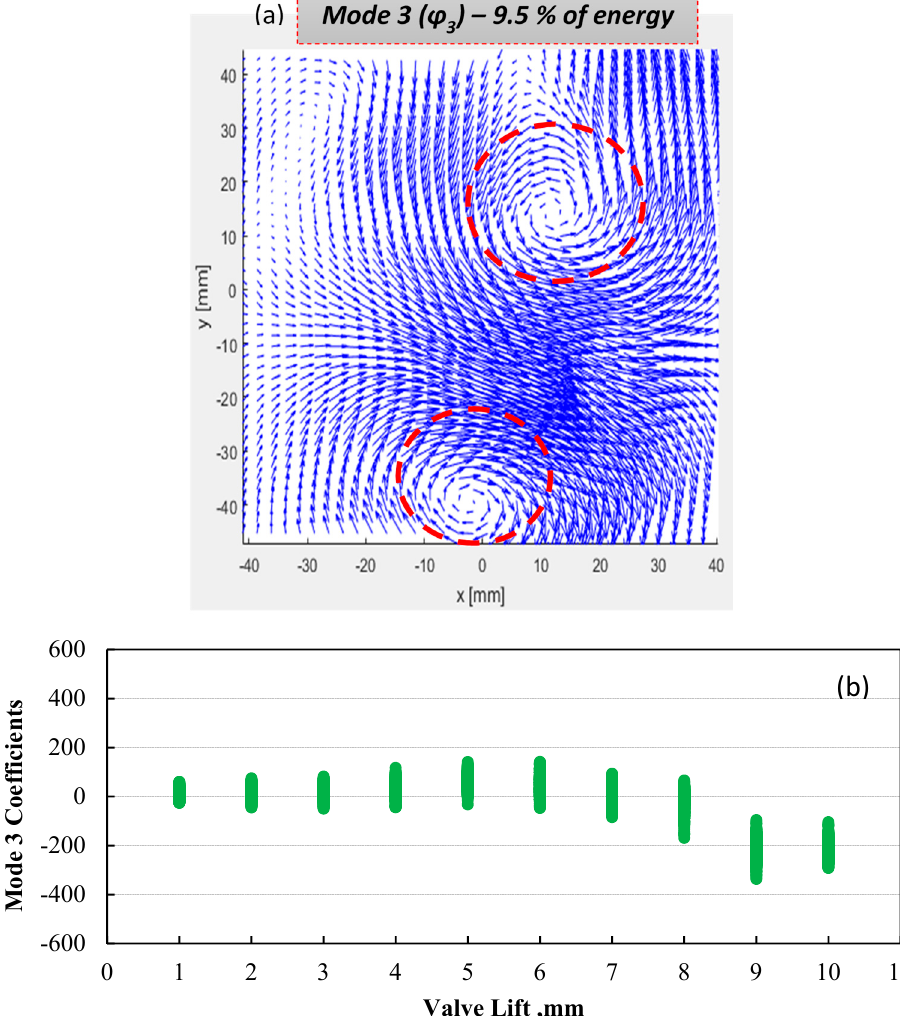
Figure 16. Flow patterns of the third POD mode ( a ) structures of modes 3; ( b ) mode 3 corresponding coefficients at different valve lifts.